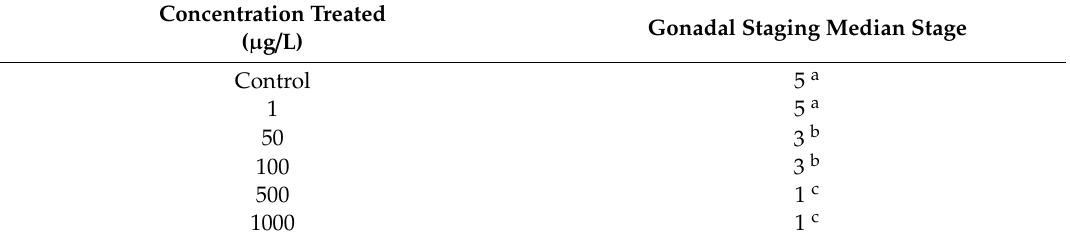
abc —indicates a significant di ff erence ( p < 0.05) between the